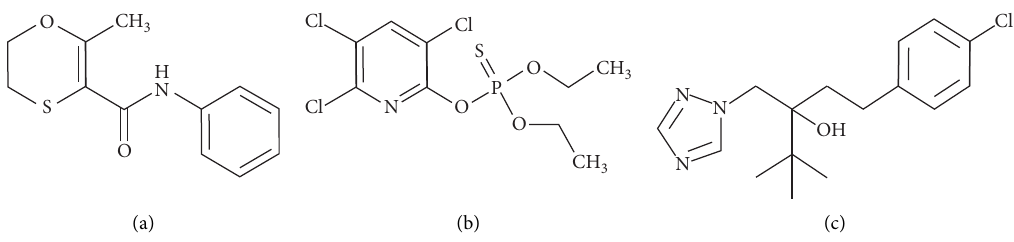
Figure 1: The structure of (a) carboxin, (b) chlorpyrifos, and (c)